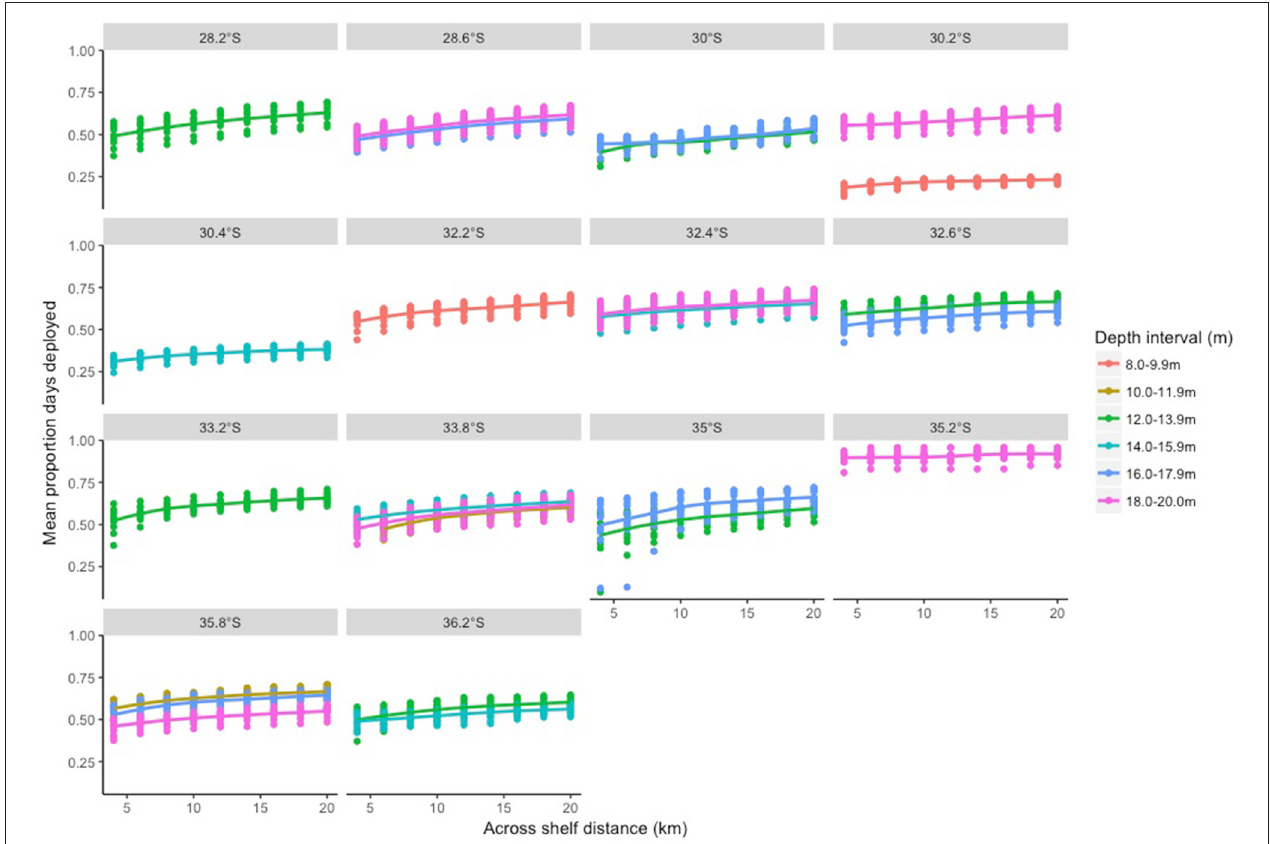
FIGURE 5 | Mean proportion of days that loggers were deployed that had corresponding satellite data for different across-shelf distances.